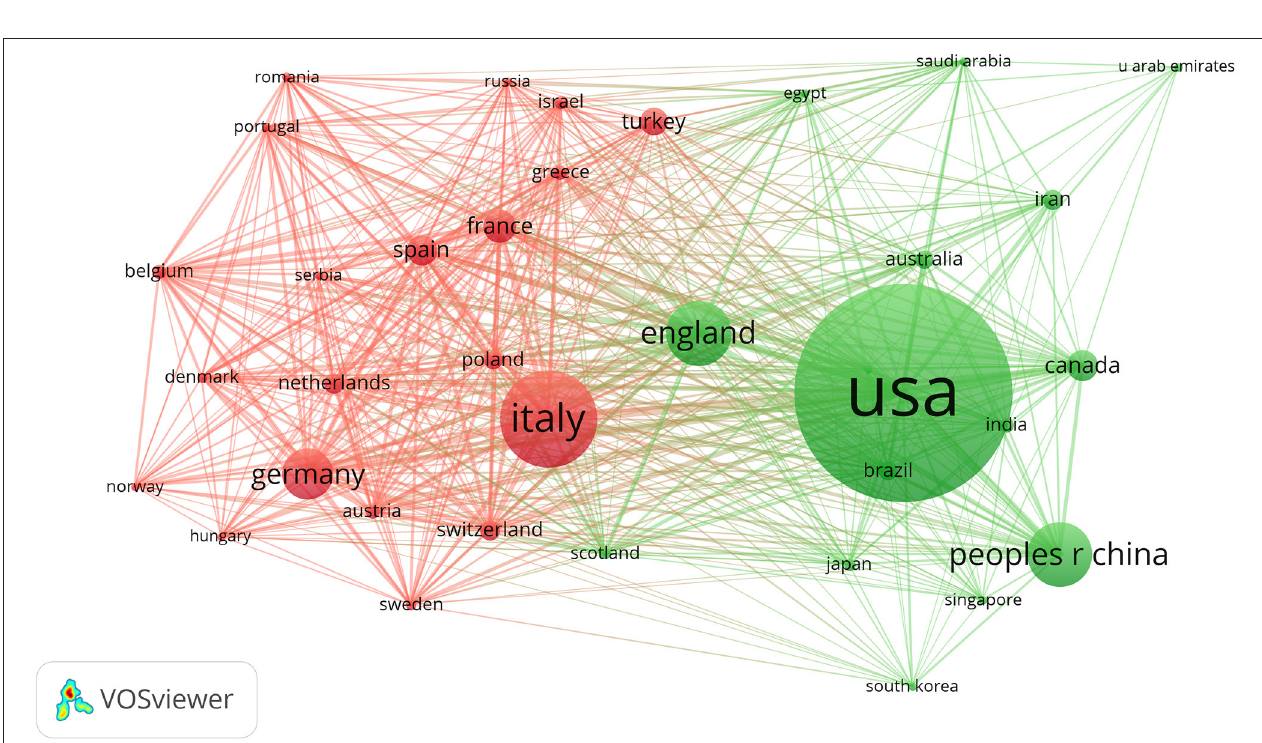
Frontiers in Cardiovascular Medicine | www.frontiersin.org 3 July 2022 | Volume 9 | Article